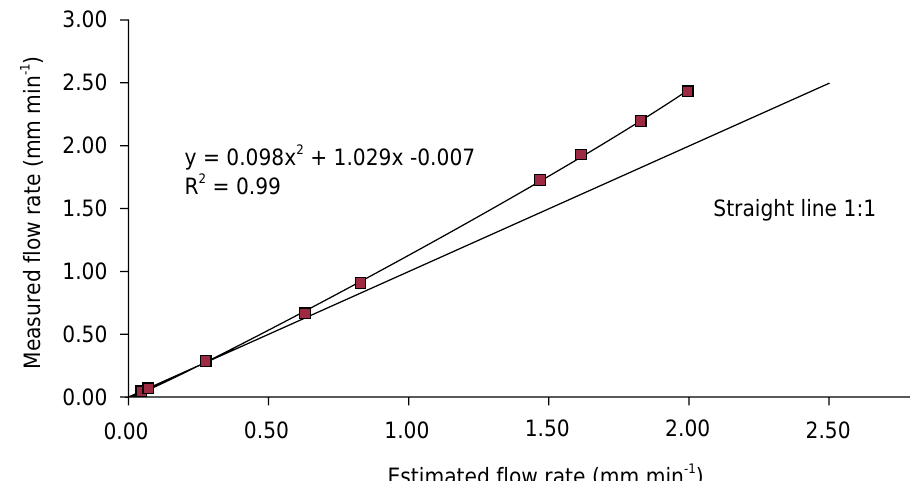
Figure 4. Calibration curve for the